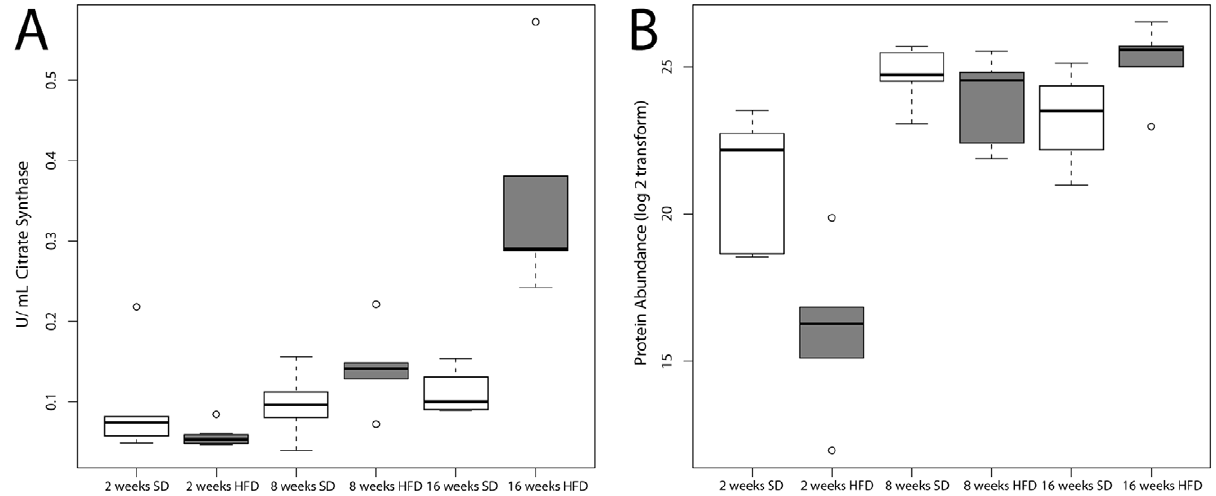
Figure 5. Comparison of citrate synthase activity measured by an activity assay and by LC-MS based ABPP using ATP-ABP . (A) The citrate synthase activity was measured for each skeletal muscle mitochondrial lysates from individual mice. Results show the mean + / 2 standard error. (B) Protein abundance identified by ATP-ABP labeling of citrate synthase. Results show the mean of the abundance measured by MS + / 2 standard error. A single outlier at 2- and 16-week time points was removed from the HFD group. Each box in (A) and (B) contains all measured data for each point. The line within the box indicates the mean, and capped dashed lines represent the standard error from the mean.